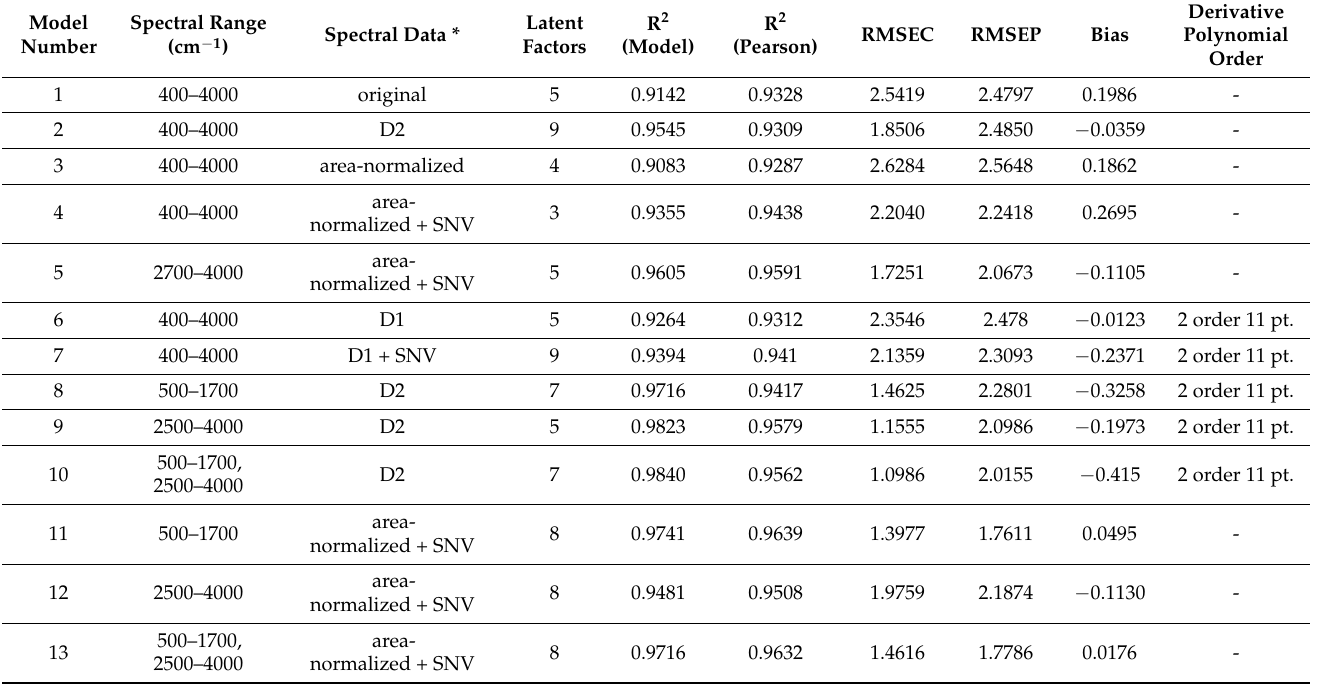
Table 1. HPLC method validation results. Table 2. The developed PLSR models and models parameter.